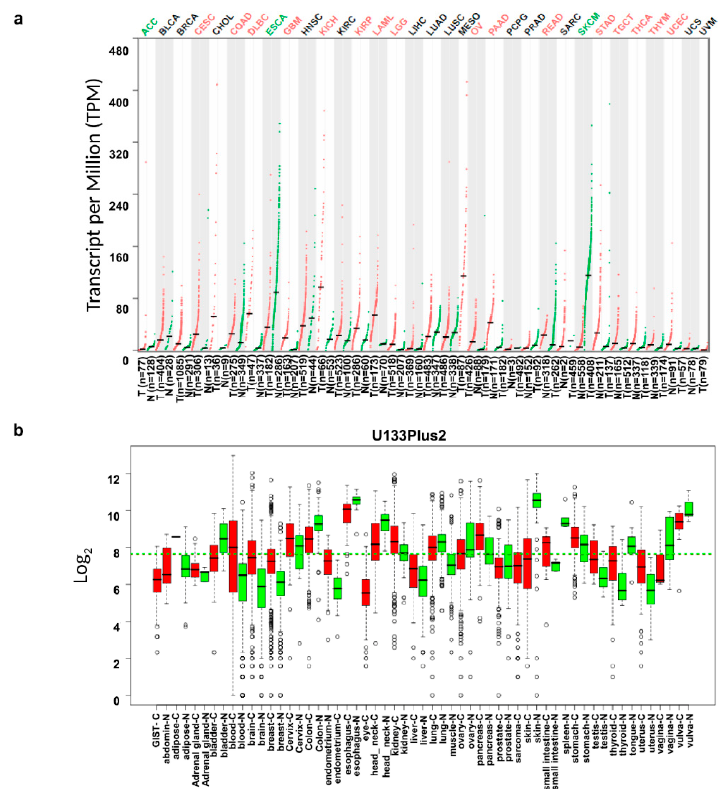
Figure 1. Transcription levels of interleukin-18 ( IL18 ) in different types of cancer and normal tissues. ( a ) Expression of IL18 in various types of cancer and normal tissues visualized as dot plots based on the RNA-seq data from the Cancer Genome Atlas (TCGA) and Genotype-Tissue Expression (GTEx) datasets through the Gene Expression Profiling Interactive Analysis (GEPIA) website (http://gepia.cancer-pku.cn/). Abbreviations of cancers types are presented in Supplementary Table S1. Cancer types in which IL18 expression was significantly higher or lower than normal tissues are marked as red or green, respectively. ( b ) IL18 mRNA expression in various types of cancer from the Gene Expression across Normal and Tumor tissue (GENT) database [25]. The boxplots show mRNA expression data from each cancer and normal tissue profiled by the U133plus platforms. Boxes show the median and the 25th and 75th percentiles; dots are outliers. Red boxes represent tumor tissues; green boxes represent normal tissues. Red and green dashed lines represent the average value of all tumor and normal tissues, respectively.